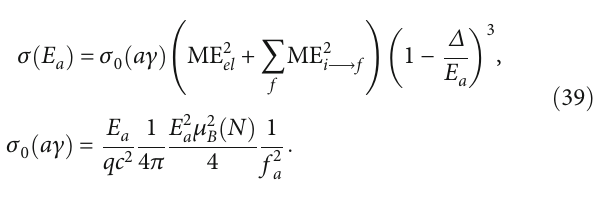
Figure 2: A Feynman diagram relevant for axion-induced beta